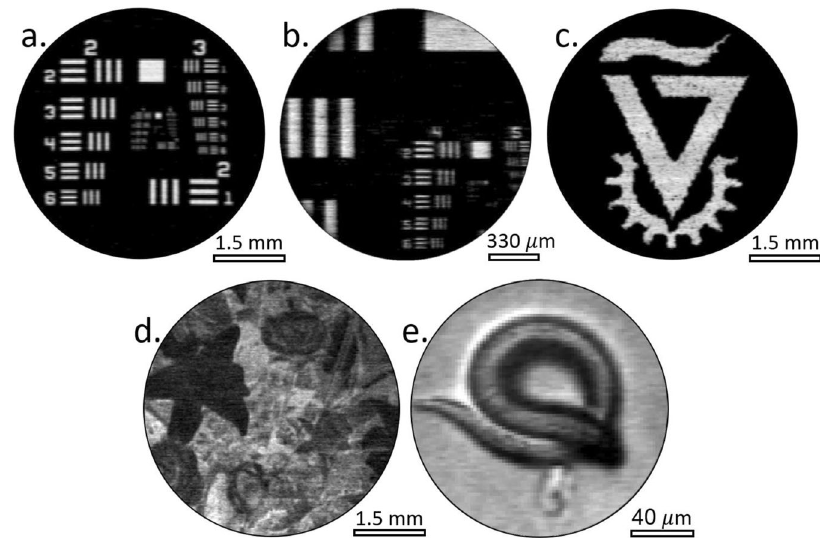
Fig. 3 Experimental results captured by our system for several mask con fi gurations. Images ( a and b ) are of a resolution target, c is a slide of the Technion logo, d is an image of an old photographic fi lm with a photo of fl owers (comparison to a camera reference is given in Supplementary Note 6), and ( e ) is a microscopy image of a C. elegans worm. Images ( a – d ) have 25k pixels and image ( e ) has 10k pixels. Additional con fi guration details are found in Supplementary Note 2.